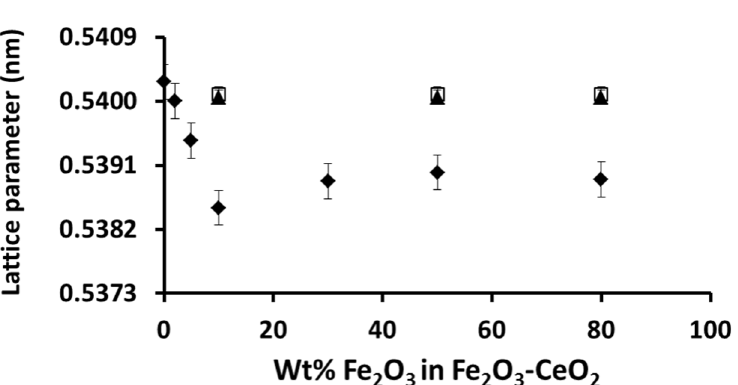
Figure 6. Unit cell parameters for ceria in a series of x wt% Fe 2 O 3 –CeO 2 with variable Fe 2 O 3 loading (diamond) as prepared, (triangle) CO 2 -reoxidation and (square) O 2 -reoxidation states. Error bars represent standard deviation (68% confidence interval) [54].